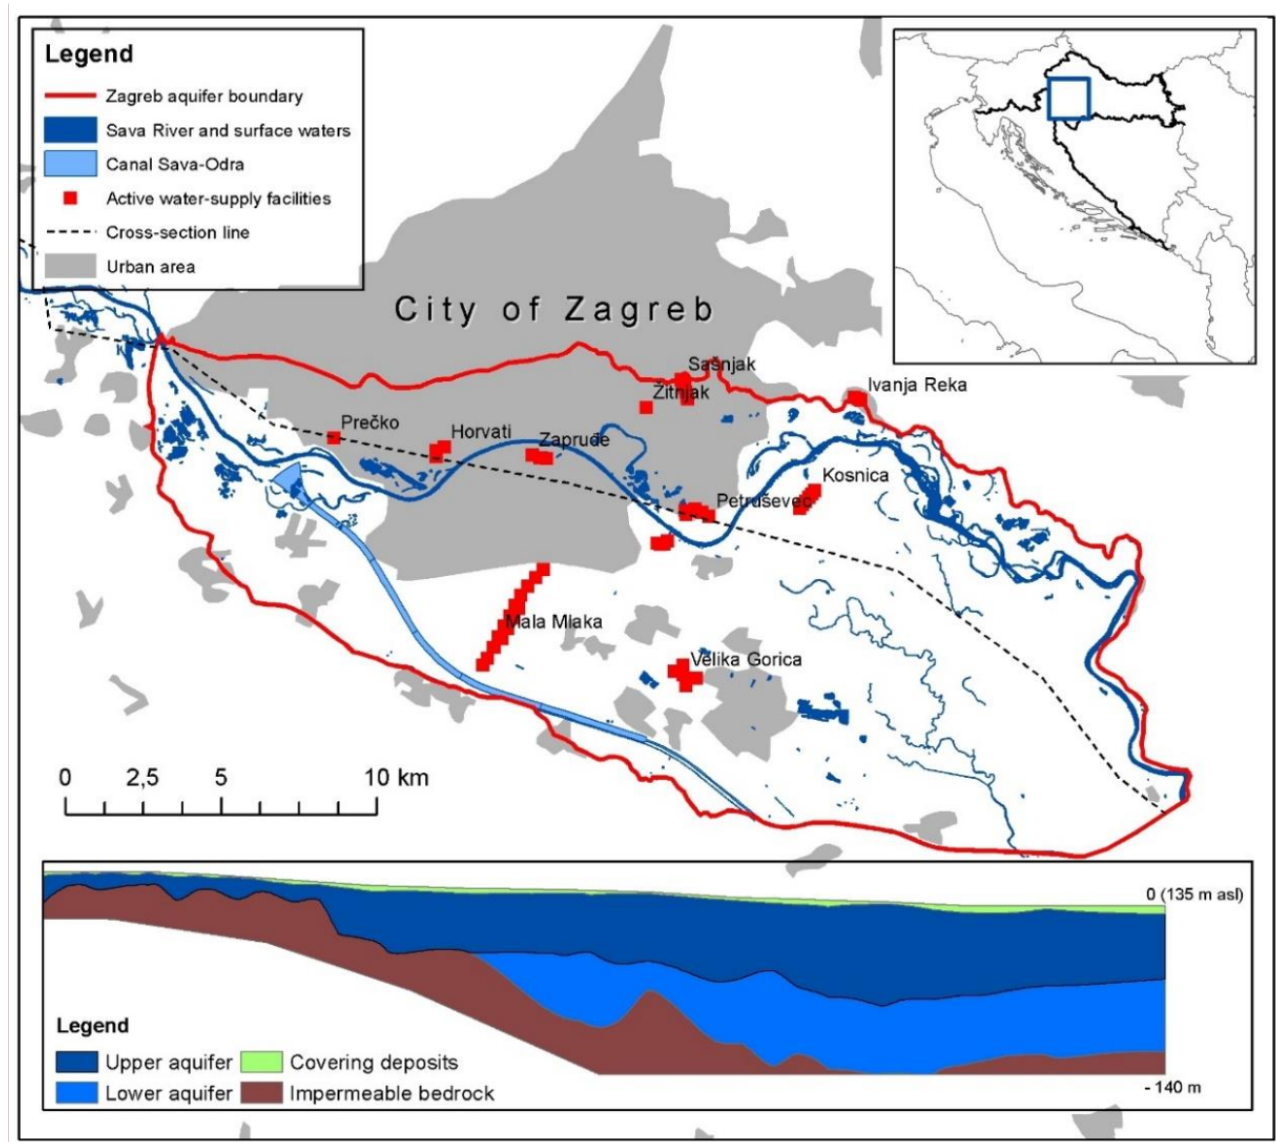
Figure 1. Zagreb aquifer position and cross